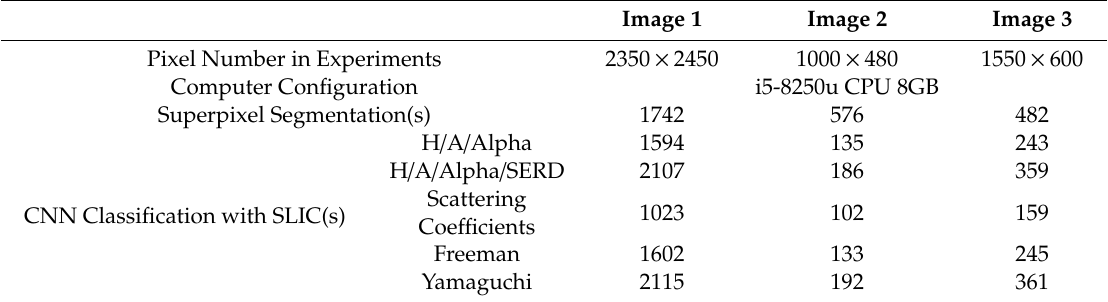
Table 9. Calculation time of each process (seconds).